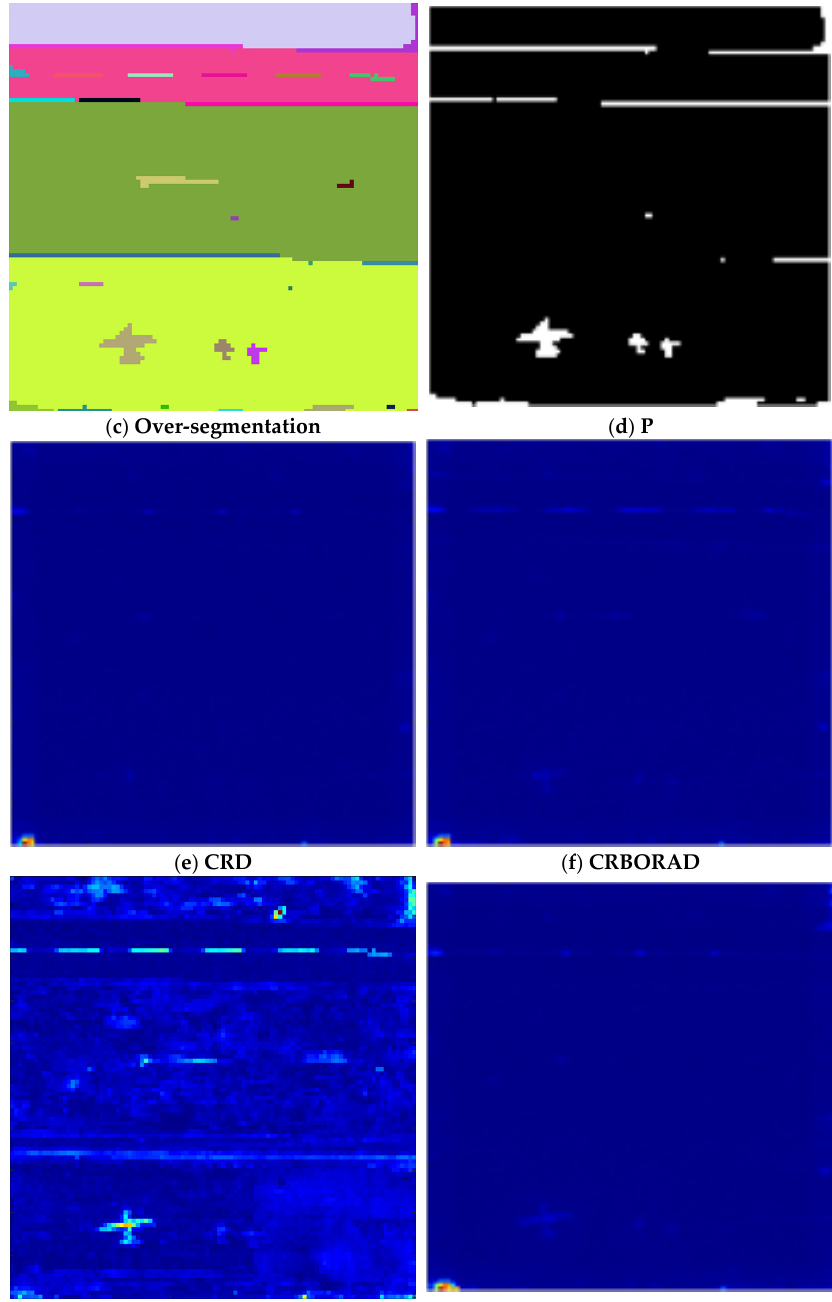
Figure 6. Color detection maps for ABU Airport dataset with dual-window sizes (11,15). ( a ) False color image; ( b ) ground-truth map; ( c ) over-segmentation; ( d ) label map P; ( e ) the detection result of CRD; ( f ) the detection result of CRBORAD; ( g ) the detection result of LRSRD; ( h ) the detection result of SSCRD.